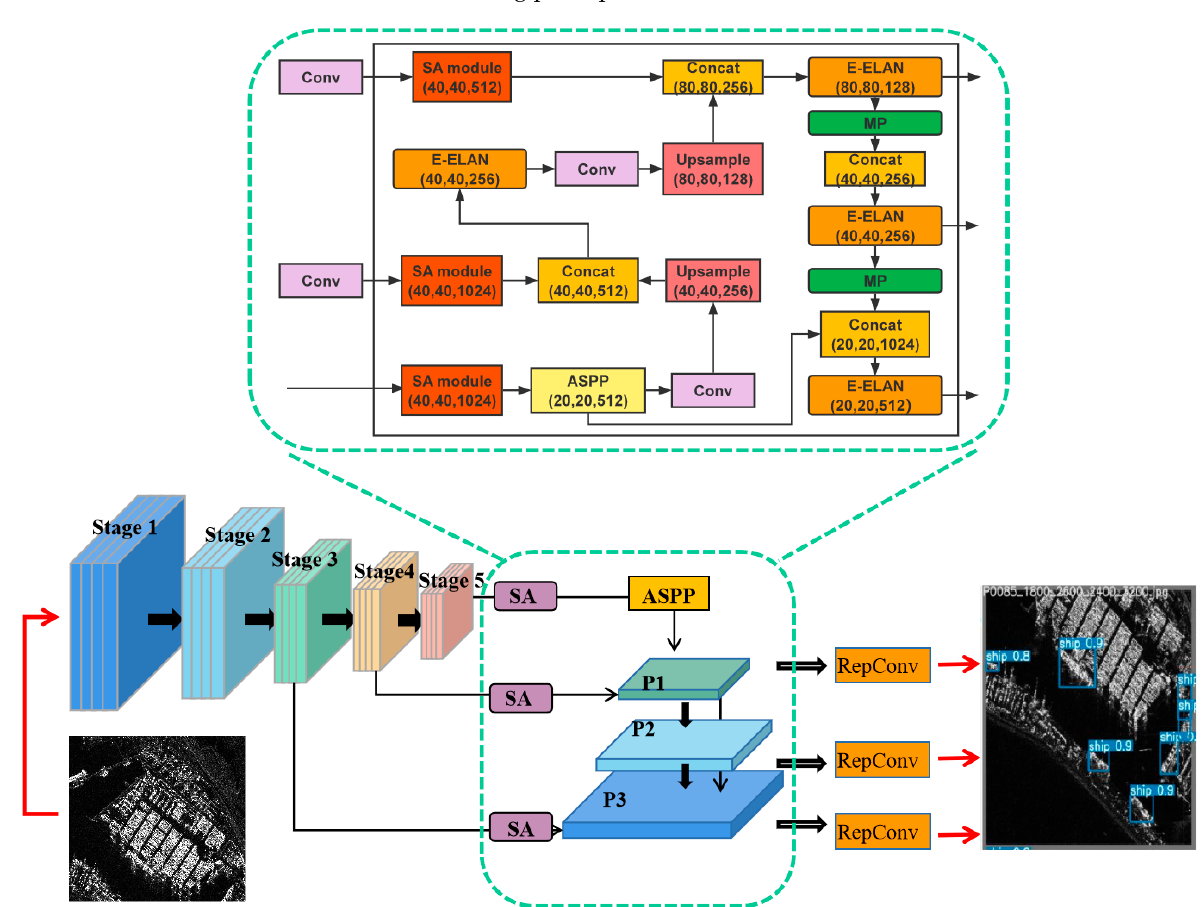
Figure 4. The flow chart of the proposed method.